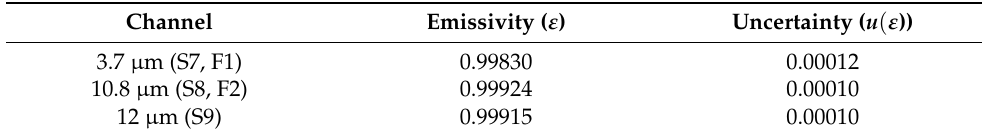
Table 7. Internal Blackbody Emissivity as Reported in [13] These values are the same for both SLSTR-A and B since it assumed that the coating and geometry are identical.